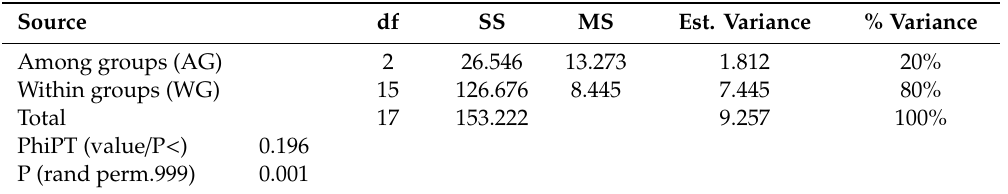
Table 5. Summary of analysis of molecular variance (AMOVA).